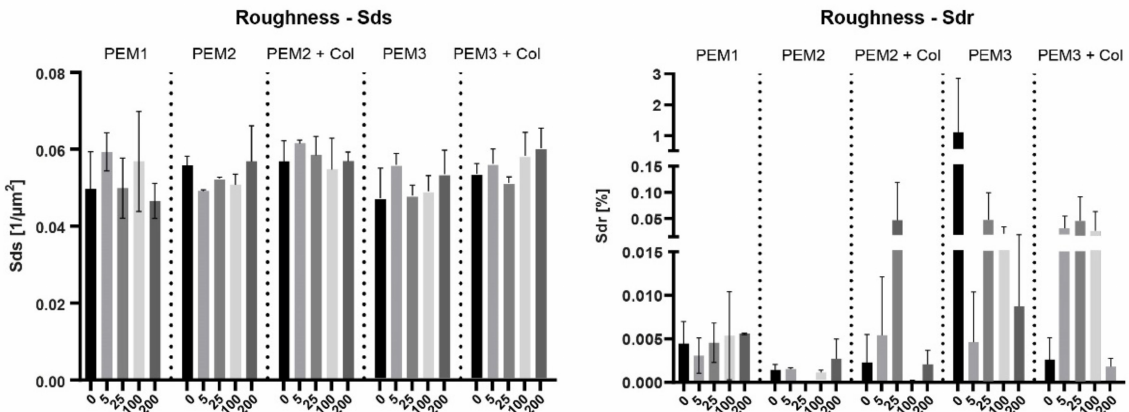
Figure 6. Roughness for EDC cross-linked PEM films. Images for the calculation of the different roughnesses were obtained from mapping with ellipsometry. Data were obtained from three inde- pendent samples and three random areas for each sample. Delta and psi values from each data point were used for modeling of the thickness for respective data points. From the grey scale images four different roughness parameters were calculated for each film